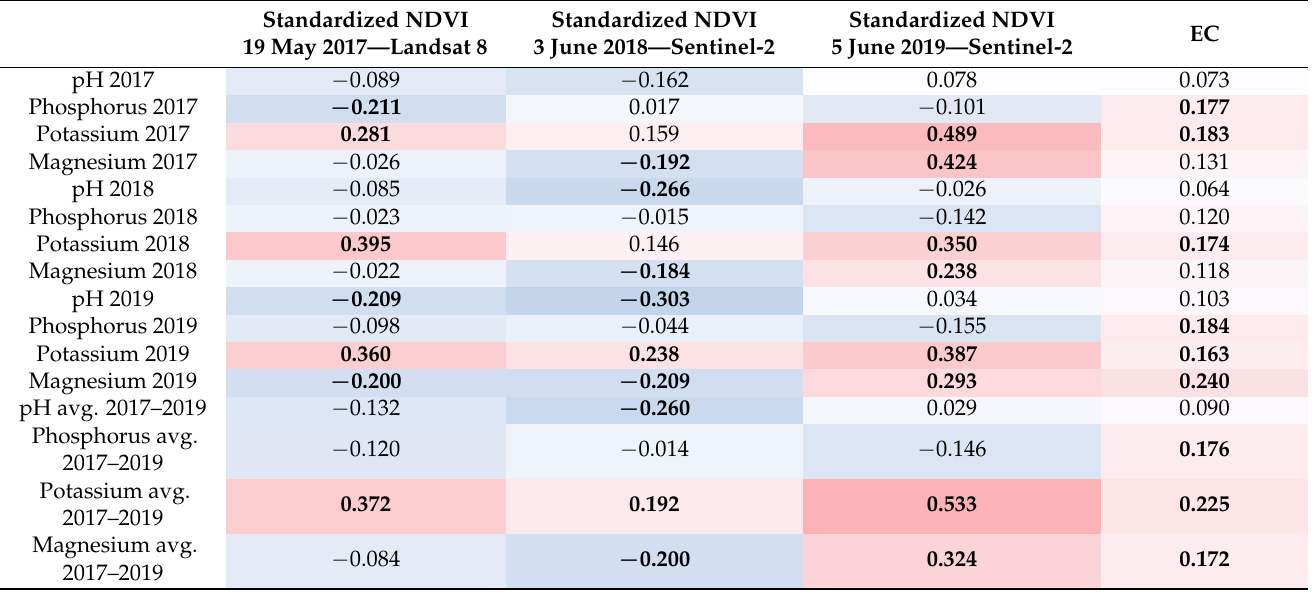
Table 8. Correlation coefficients between EC and standardized NDVI with soil pH and nutrients content for winter rapeseed (significant correlations at 0.05 significance level are in bold; color background scale for correlations the same as in Table